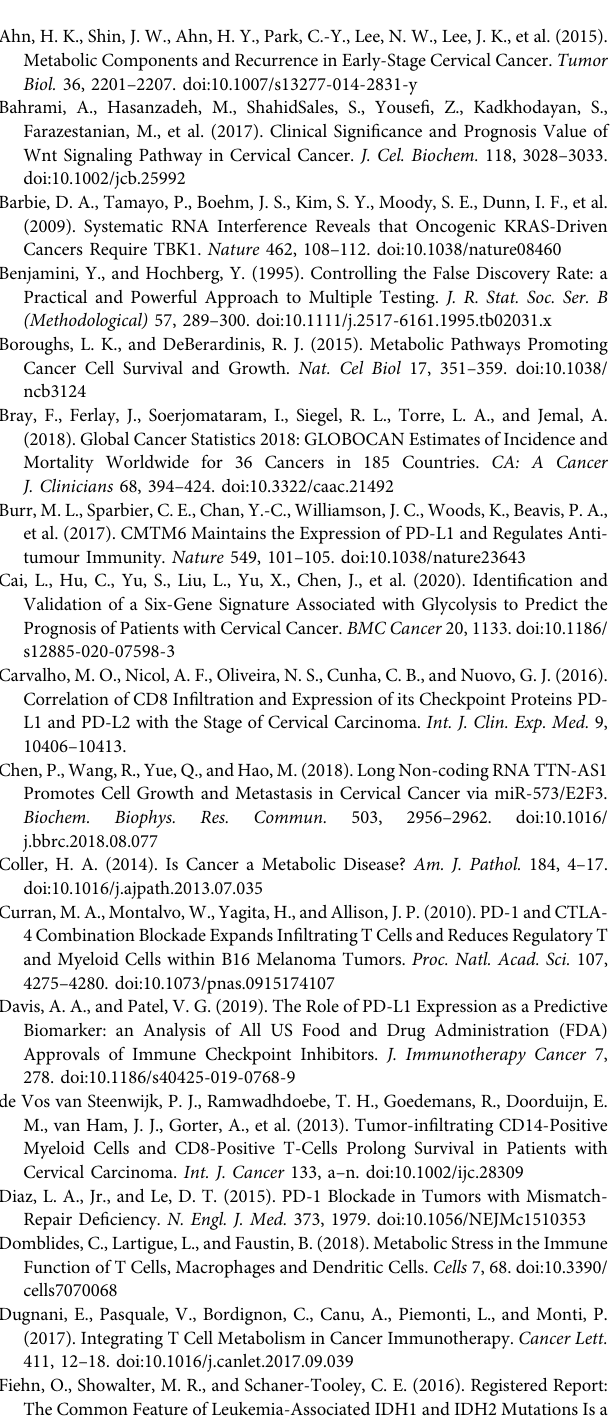
Supplementary Figure 3 | The clustering map of DEGs among the three METAclusters. Supplementary Figure 4 | Status of CNV in high- and low- METAscore groups of CESC